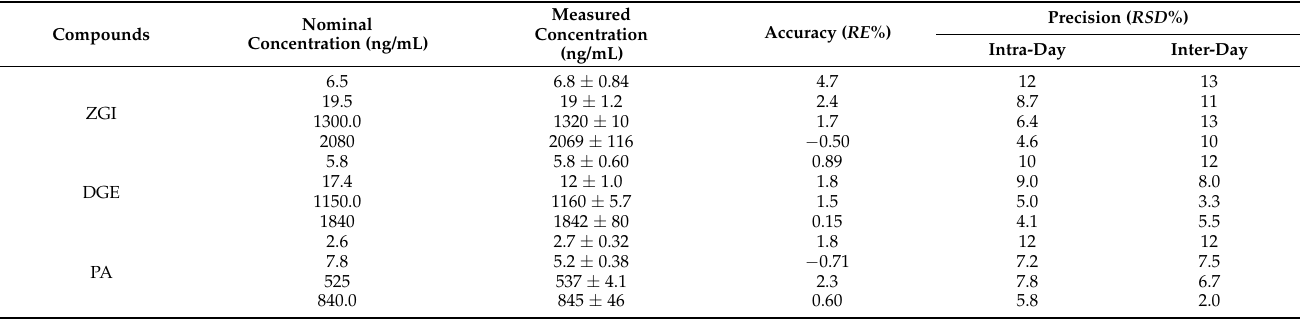
Table 2. Intra-day and inter-day precision and accuracies for the determination of the three analytes in rat plasma ( n = 6).